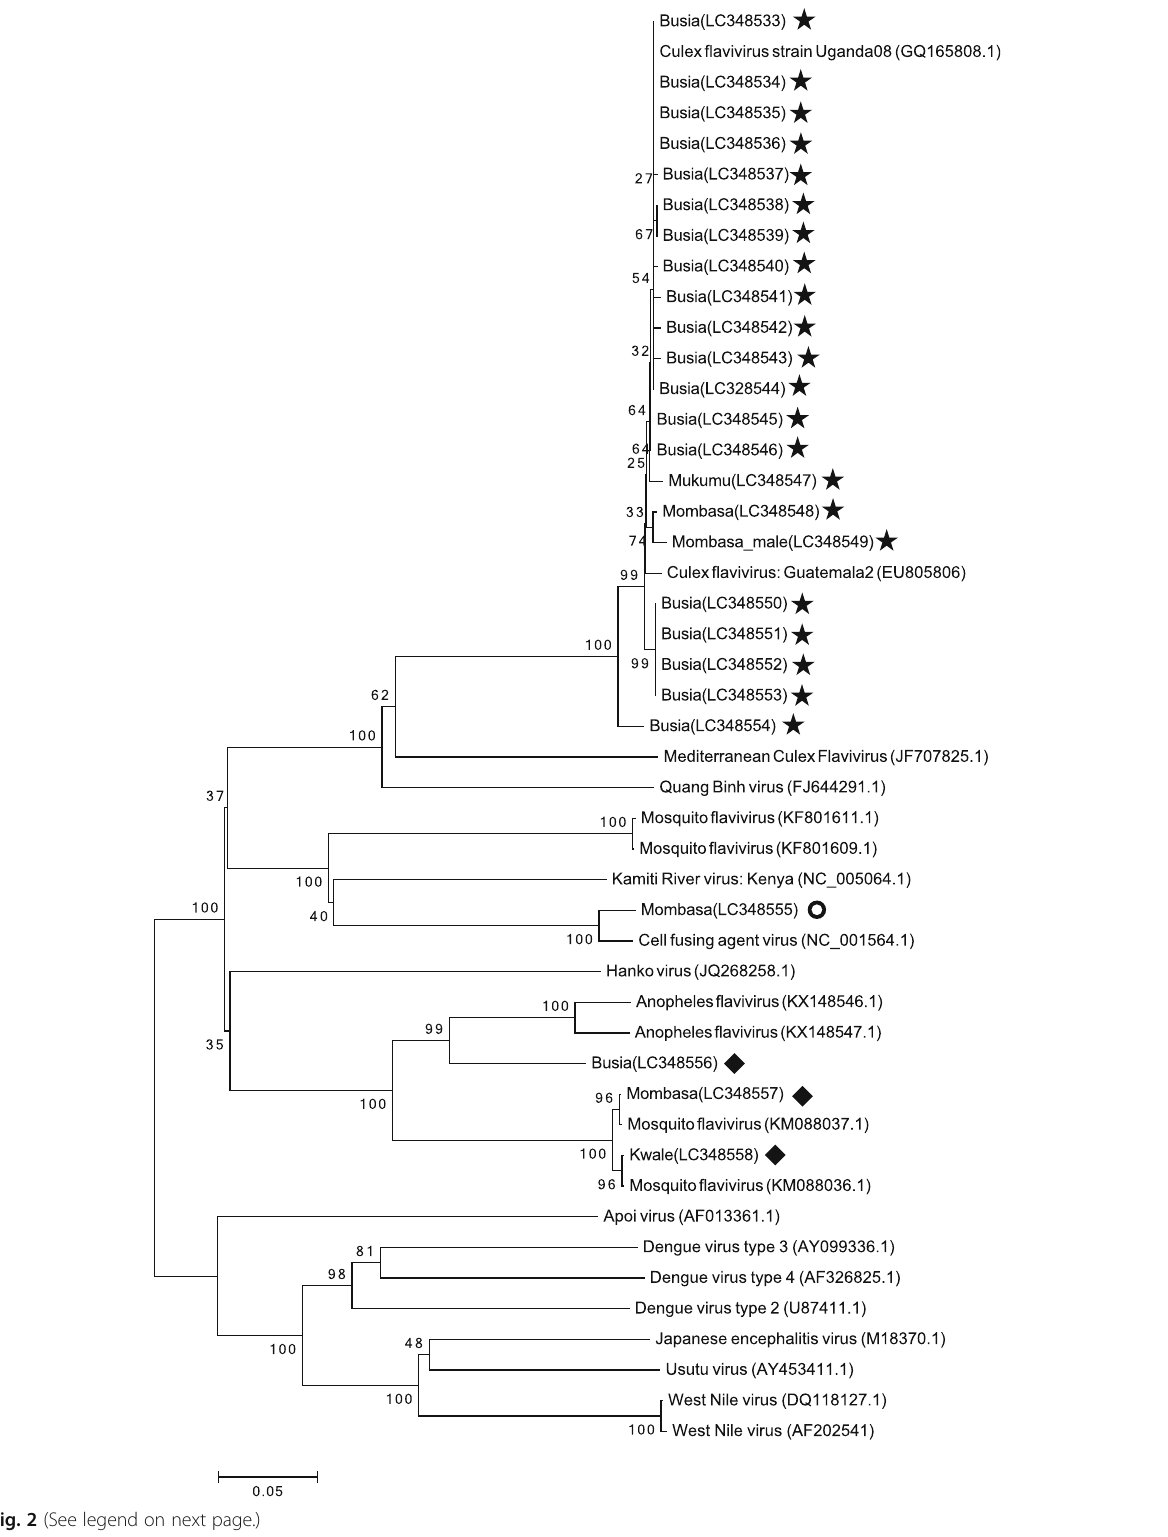
Fig. 2 (See legend on next